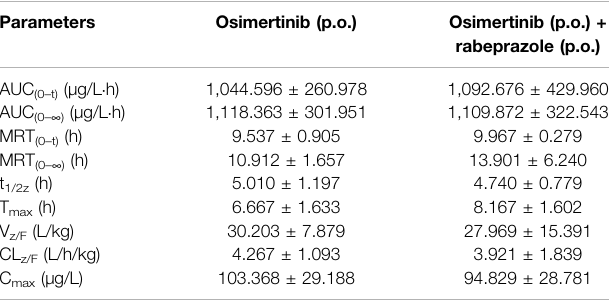
TABLE 2 | The main pharmacokinetic parameters of osimertinib in two groups of rats ( N = 6). Parameters Osimertinib (p.o.)